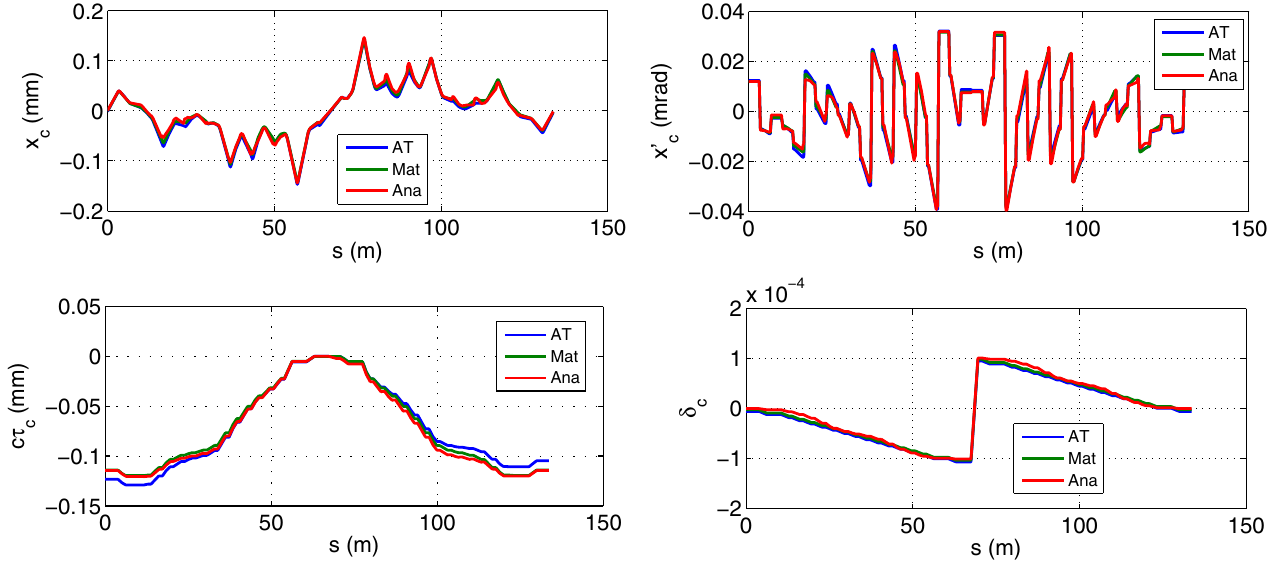
FIG. 4. (Color) The SBC-induced closed-orbit changes calculated in three different ways for the SPEAR Booster at 3 GeV. The , x 0 , c(cid:2) , and (cid:3) are shown in the four plots. The three curves are from AT (AT), matrix inversion (Mat), and the analytic changes to x c c c c solution (Ana),